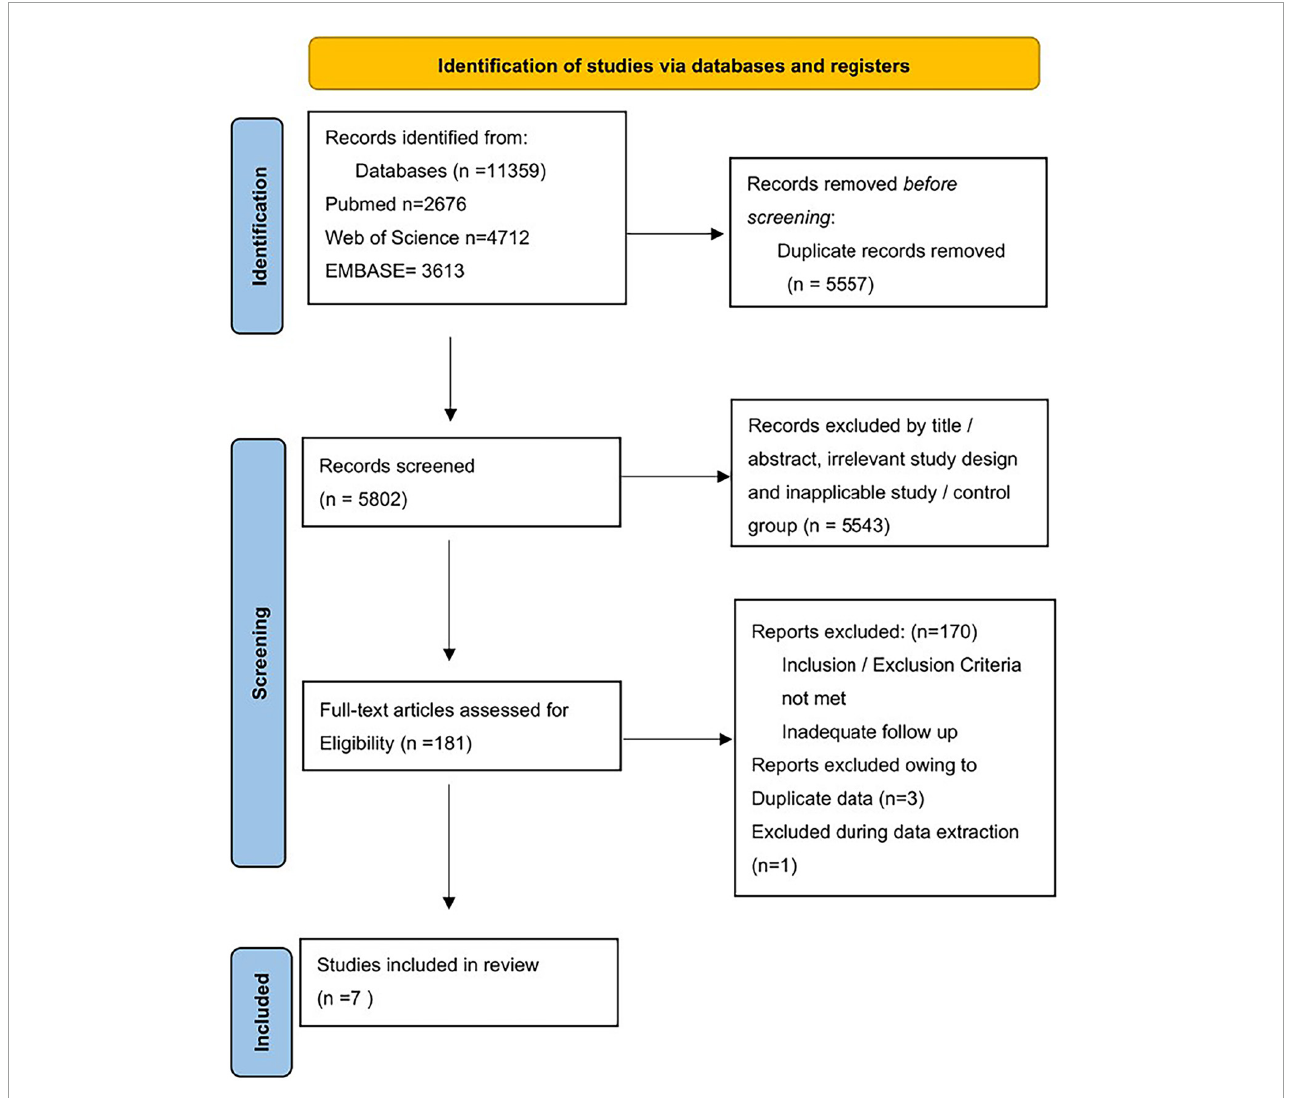
FIGURE1 Summary of electronic search and included/excluded